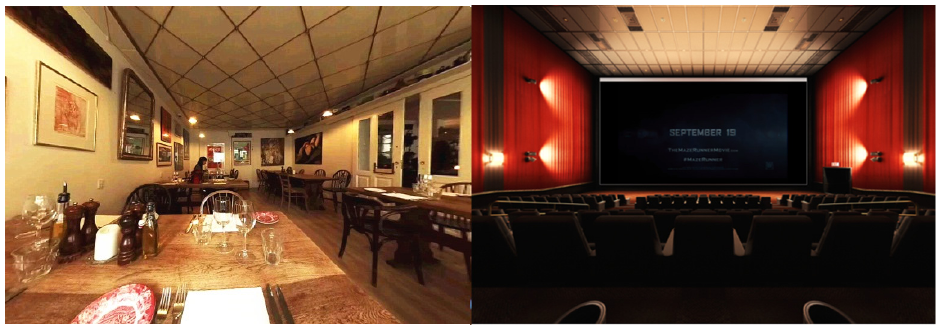
Figure 3. The casual restaurant context ( left ) and the cinema context ( right ).